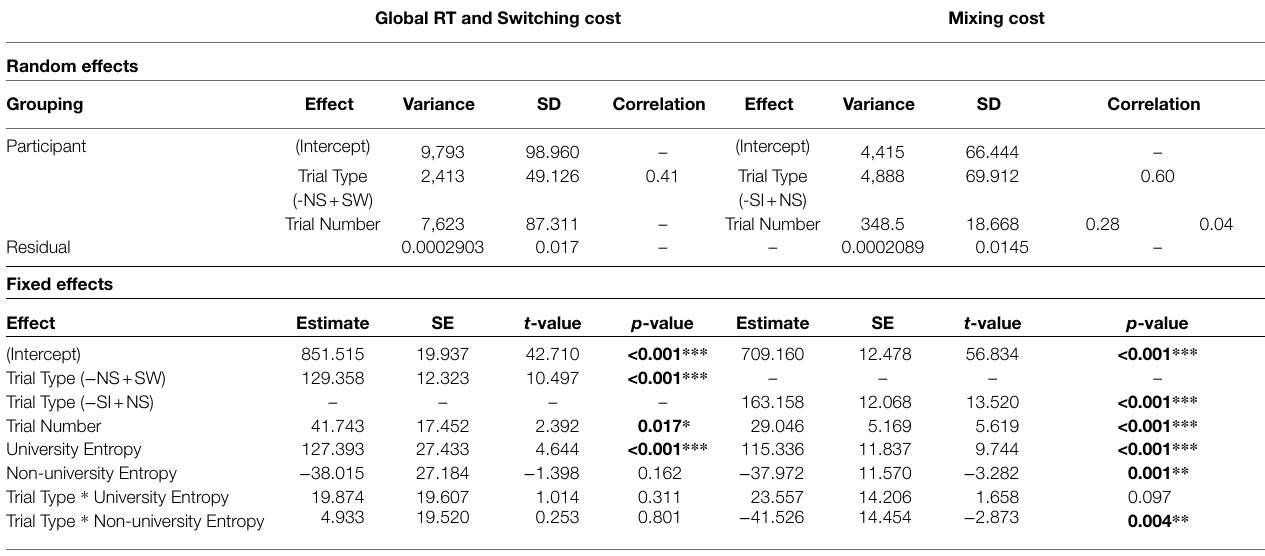
TABLE 3 | Summary of the glmer models of the effect of language entropy on global RT and switching costs (RT) as well as the effect of language entropy on mixing costs (RT) reporting the explained variance and standard deviation (SD) for the random effects, and the model estimates, standard errors (SE), t -values, and p -values for the fixed effects.